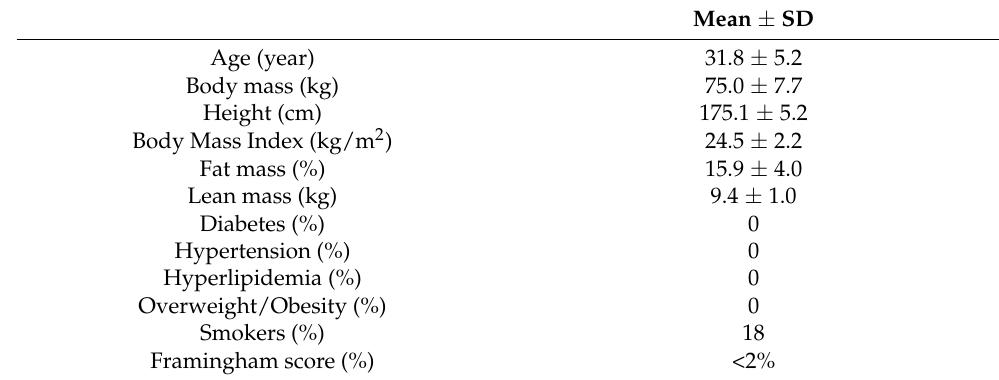
Table 1. Characteristics of firefighters ( n = 38).